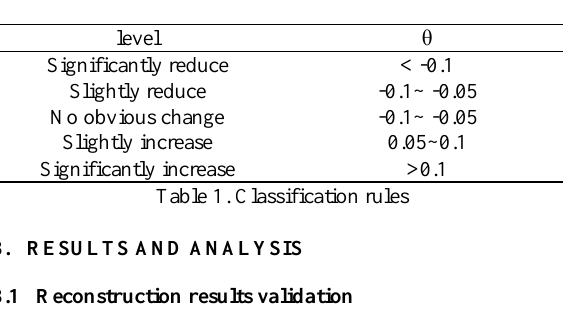
Figure 3. 15 years average LST from 2001 to